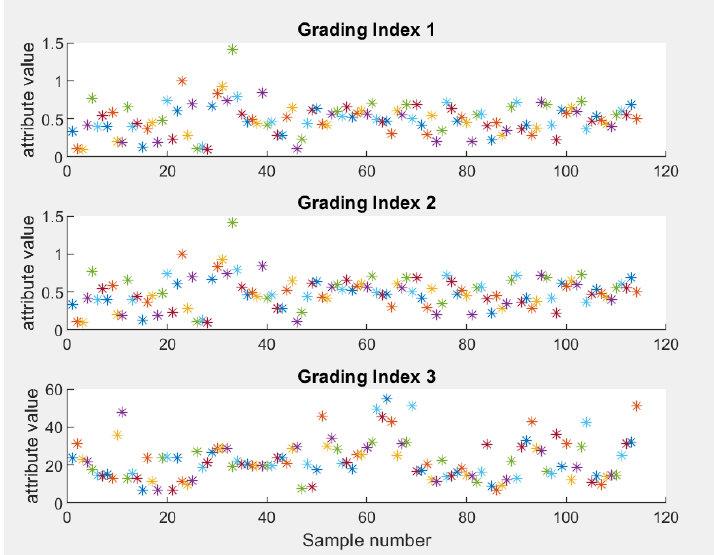
Figure 3. Fractal dimension visualization of grading indicators.